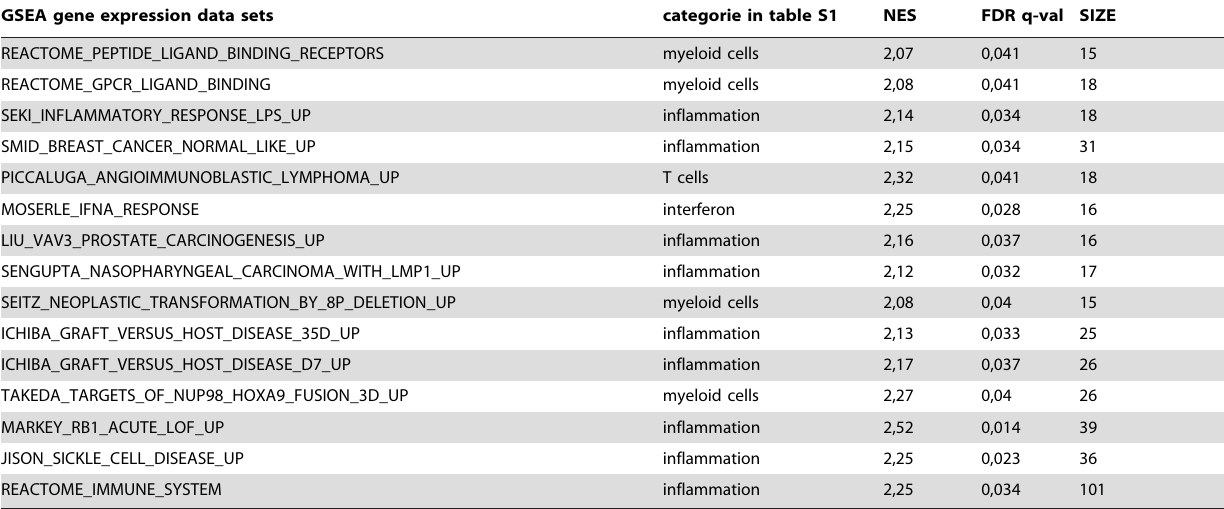
GSEA gene expression data